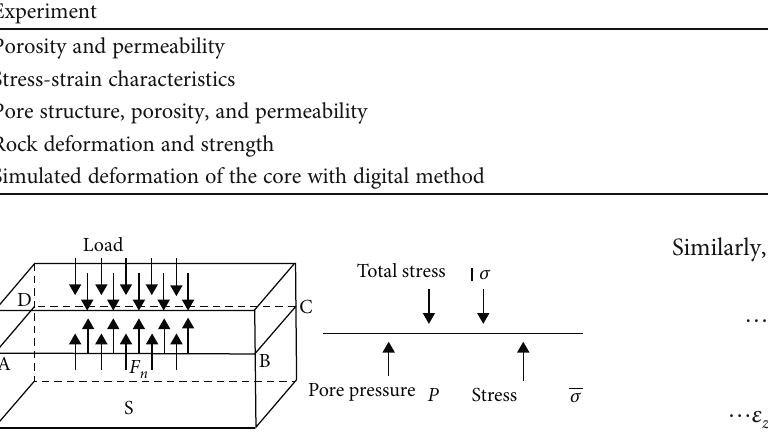
Figure 1: Simulation of rock stress and strain